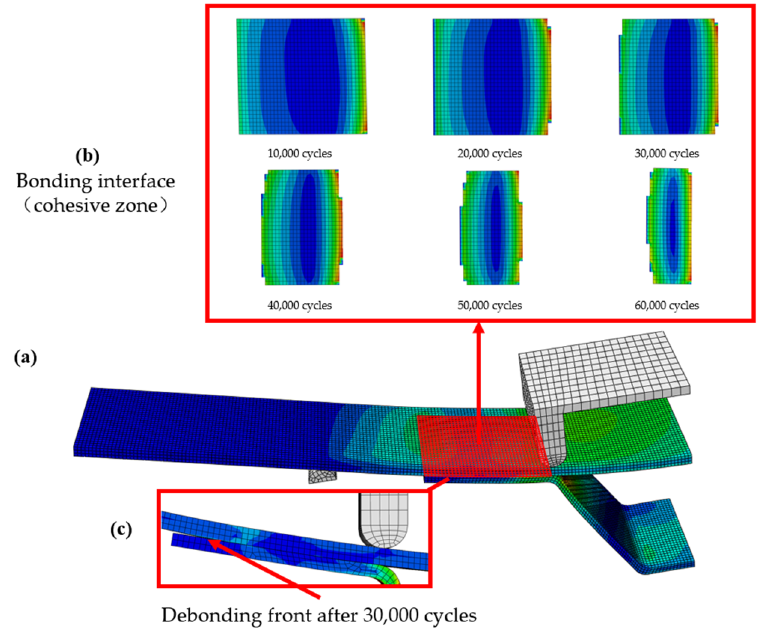
Figure 12. ( a – c ) The evolution process of interface fatigue damage in the four-point bending